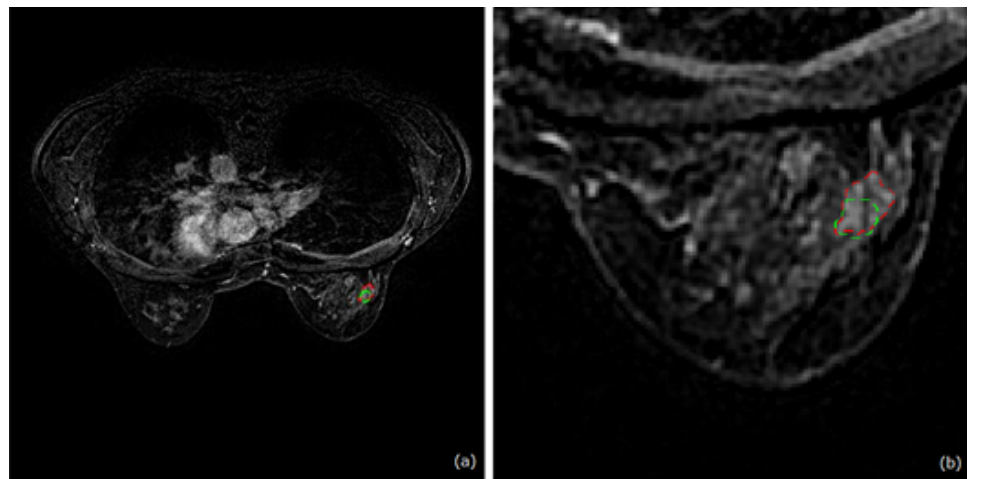
Figure 13. Case with a low-contrast lesion: ( a ) entire axial DCE-MRI slice; ( b ) crop of the slice shown in ( a ). Comparison between manual ground-truth (green) and automatic segmentation (red).